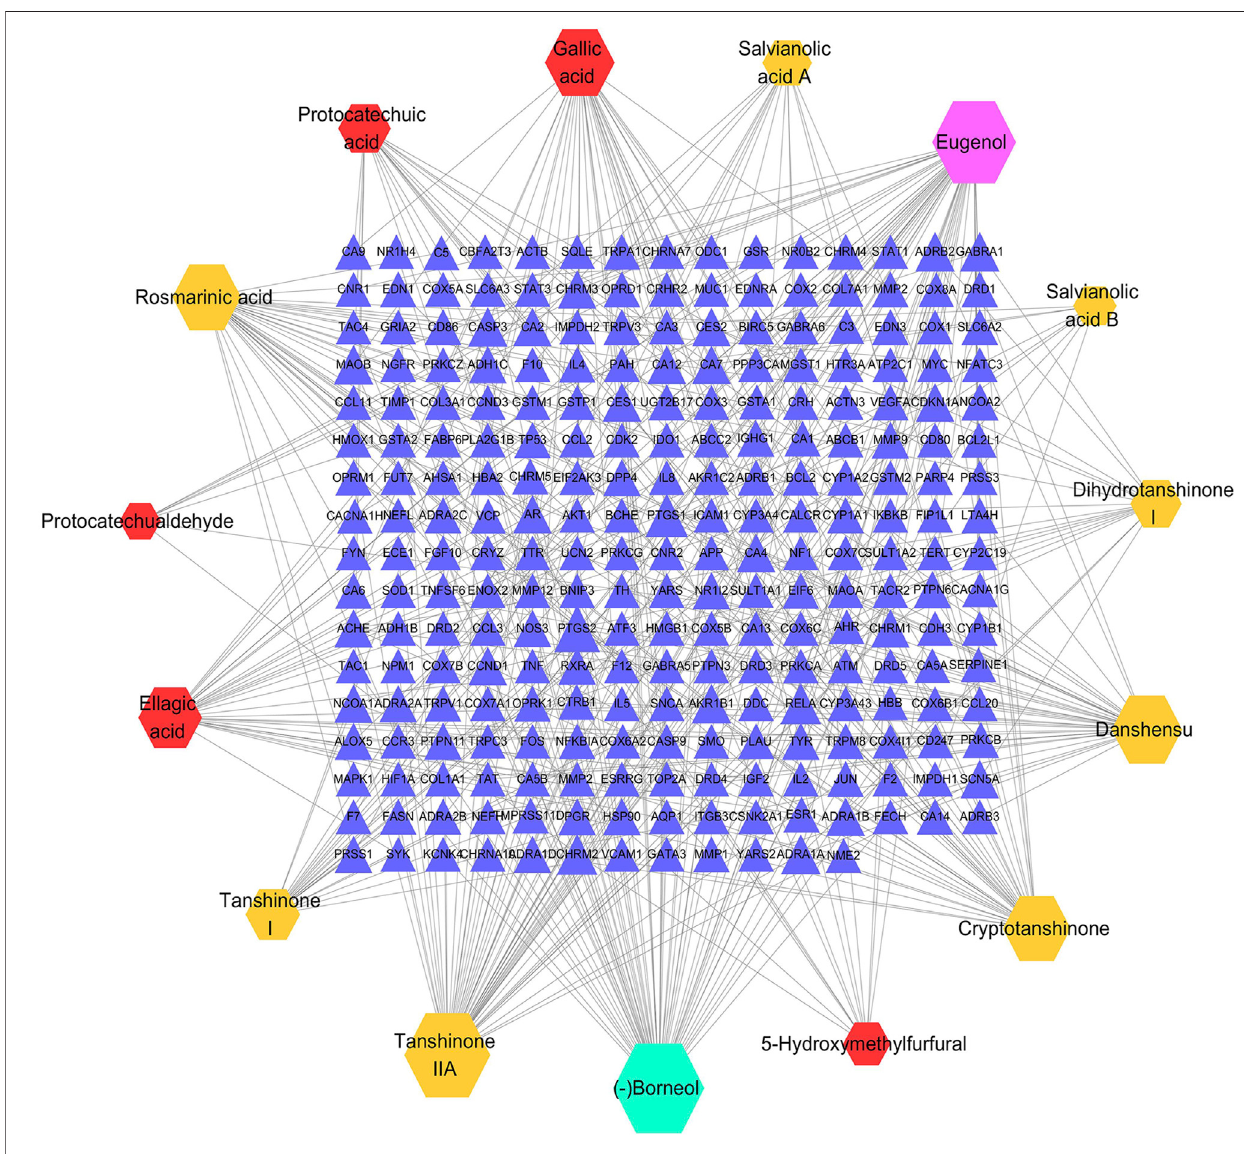
Frontiers in Pharmacology |